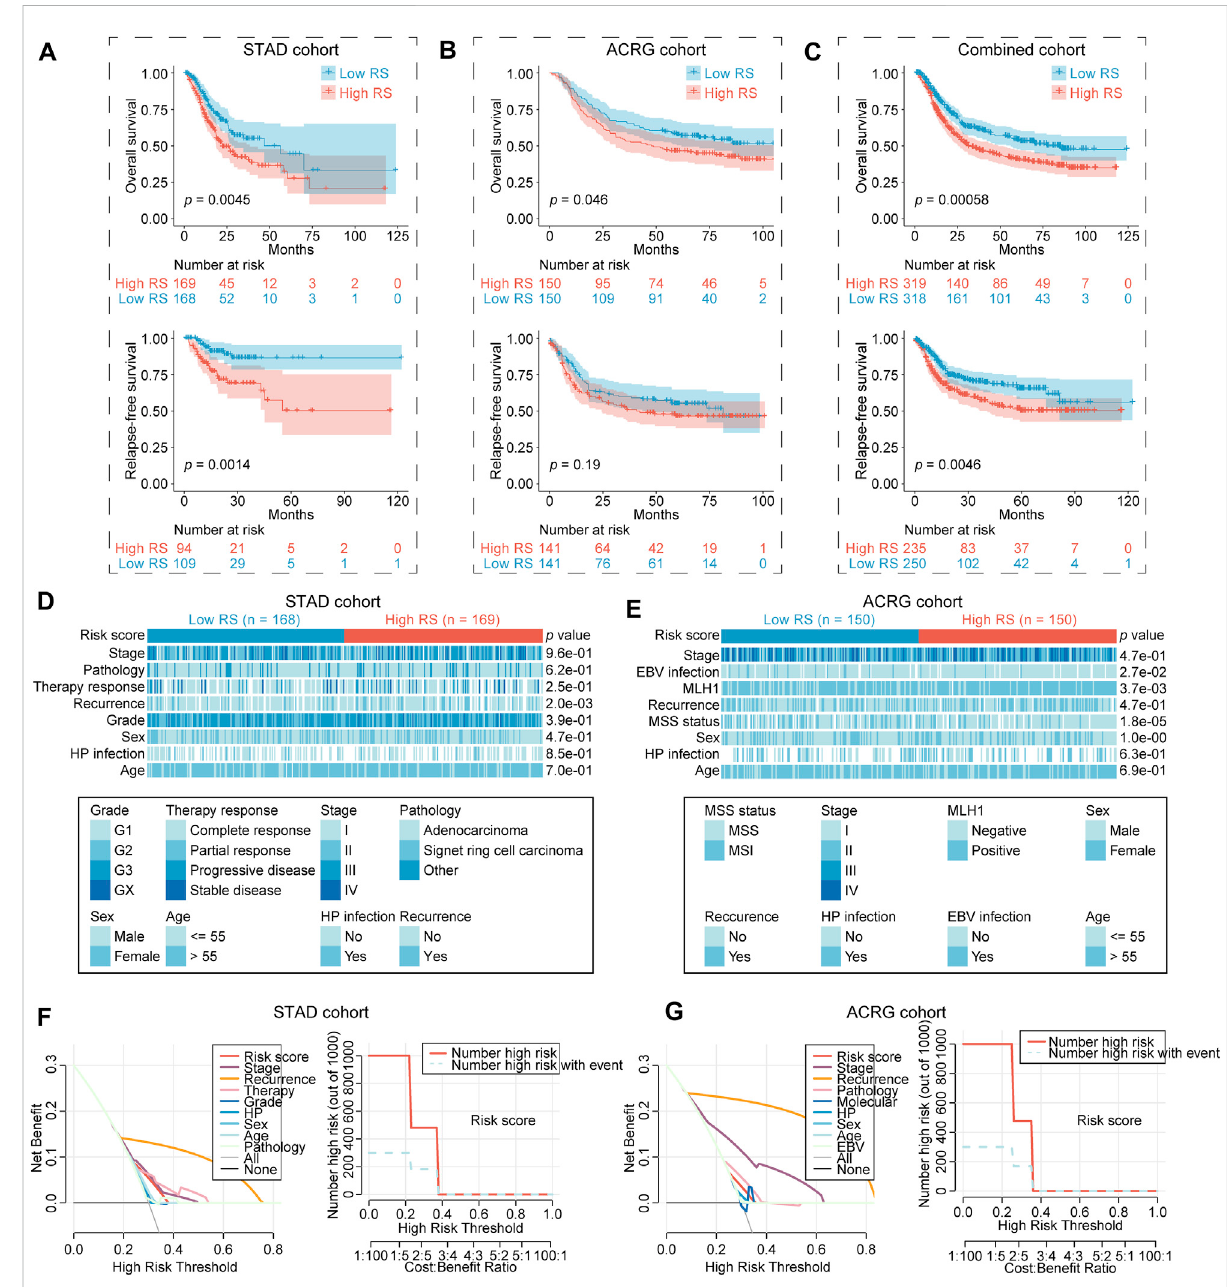
FIGURE 3 Signi fi cantdifferenceofclinicalcharacteristicsinthetwoRSgroups. (A – C) Overallsurvivalandrelapse-freesurvivaloflowandhighRSgroupin STADcohort (A) ,ACRGcohort (B) ,combinedcohort(STAD+ACRG) (C) . (D,E) ClinicalcharacteristicsoflowandhighRSgroupinSTAD (D) andACRG cohort (E) . Statistical signi fi cance of difference was determined using Chi-Square test or Fisher ’ s exact tests. (F,G) DCA of clinical characteristics in STAD (F) and ACRG cohort (G) . RS, risk score; STAD, stomach adenocarcinoma; ACRG, Asian Cancer Research Group; MSS, microsatellite stability; MSI, microsatellite instability; DCA, decision curve